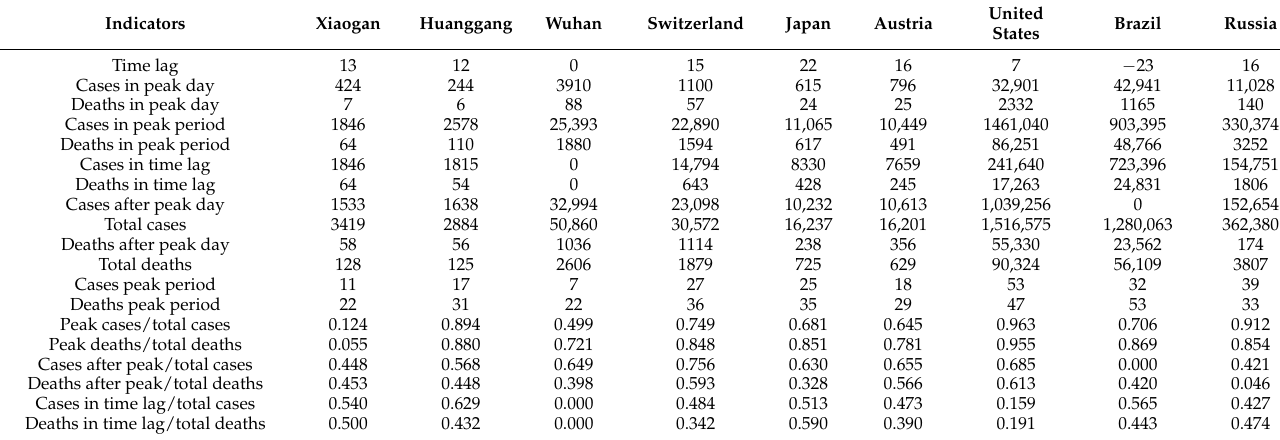
Table 1. Summary of Indicators of Cases and Deaths of Sampled Regions and Countries using data 1 of an average of 7-day.